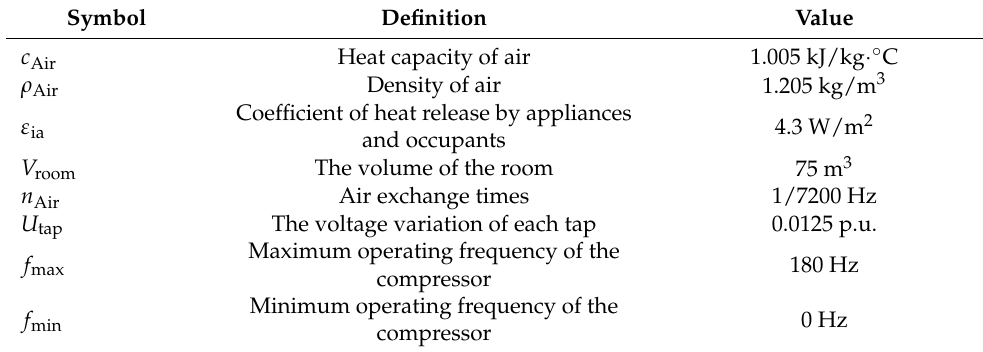
Table 1. Units for Magnetic Properties.